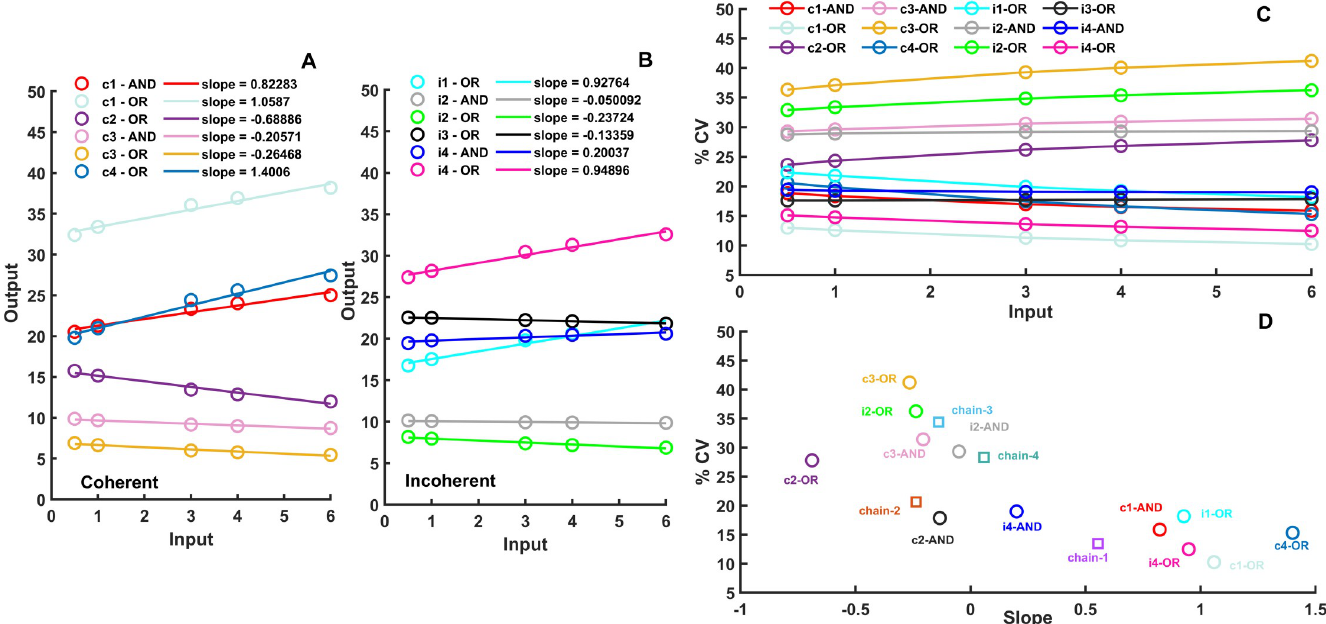
Fig 2. Signal transducing and noise reducing capabilities of linear chain and simple feed-forward loop network motifs. Mean input–mean output relation in the investigated post-translational coherent (A) and incoherent (B) FFLs observed at 5 different input levels. The noise reducing capabilities—measured by the coefficient of variation in percentage (%CV) at all tested input values in all FFLs (C). The coefficient of variations in percentage (%CV) of panel C at input = 6 is plotted against the slopes of the input-output relations of panels A and B to show how each network performs in noise reduction and signal transduction (D). The performance of linear chain motifs (S6 Fig) is also added to panel D. All simulations were run with one-step post-translational modification models and the fixed parameter sets presented in the S1 Text.